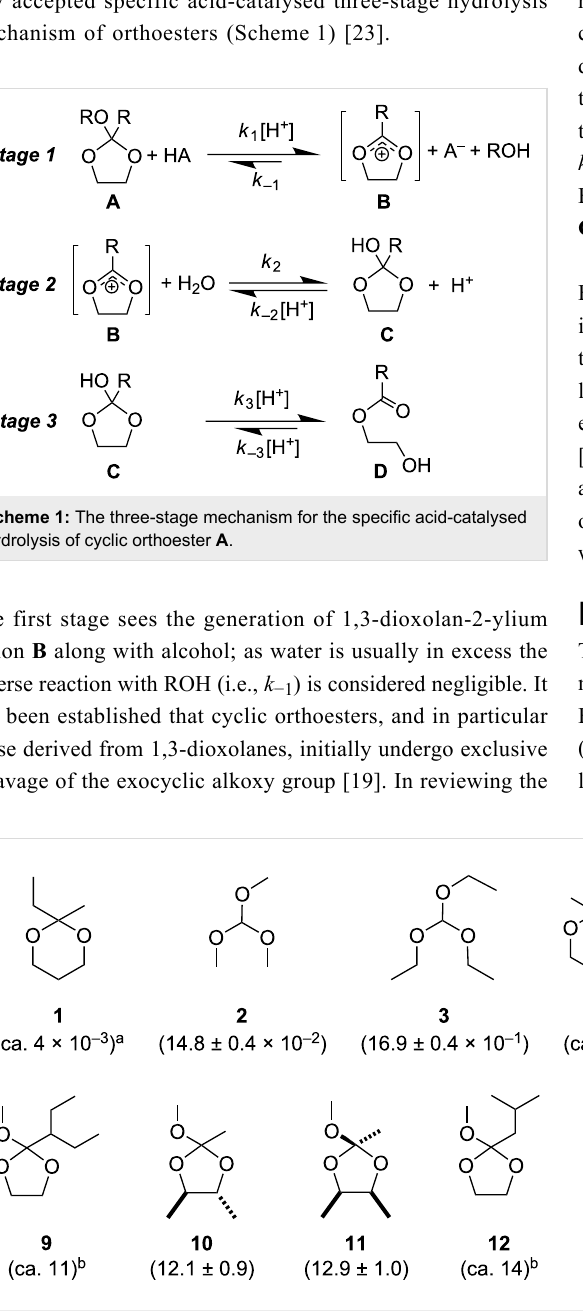
Figure 1: Hydroxonium catalytic coefficients ( k H+ M − 1 s − 1 including standard errors where appropriate) for 1–16 as determined in this study. a,b Values of k H+ determined via calibration with respect to 8 [18] and 16 [23], respectively (see Experimental